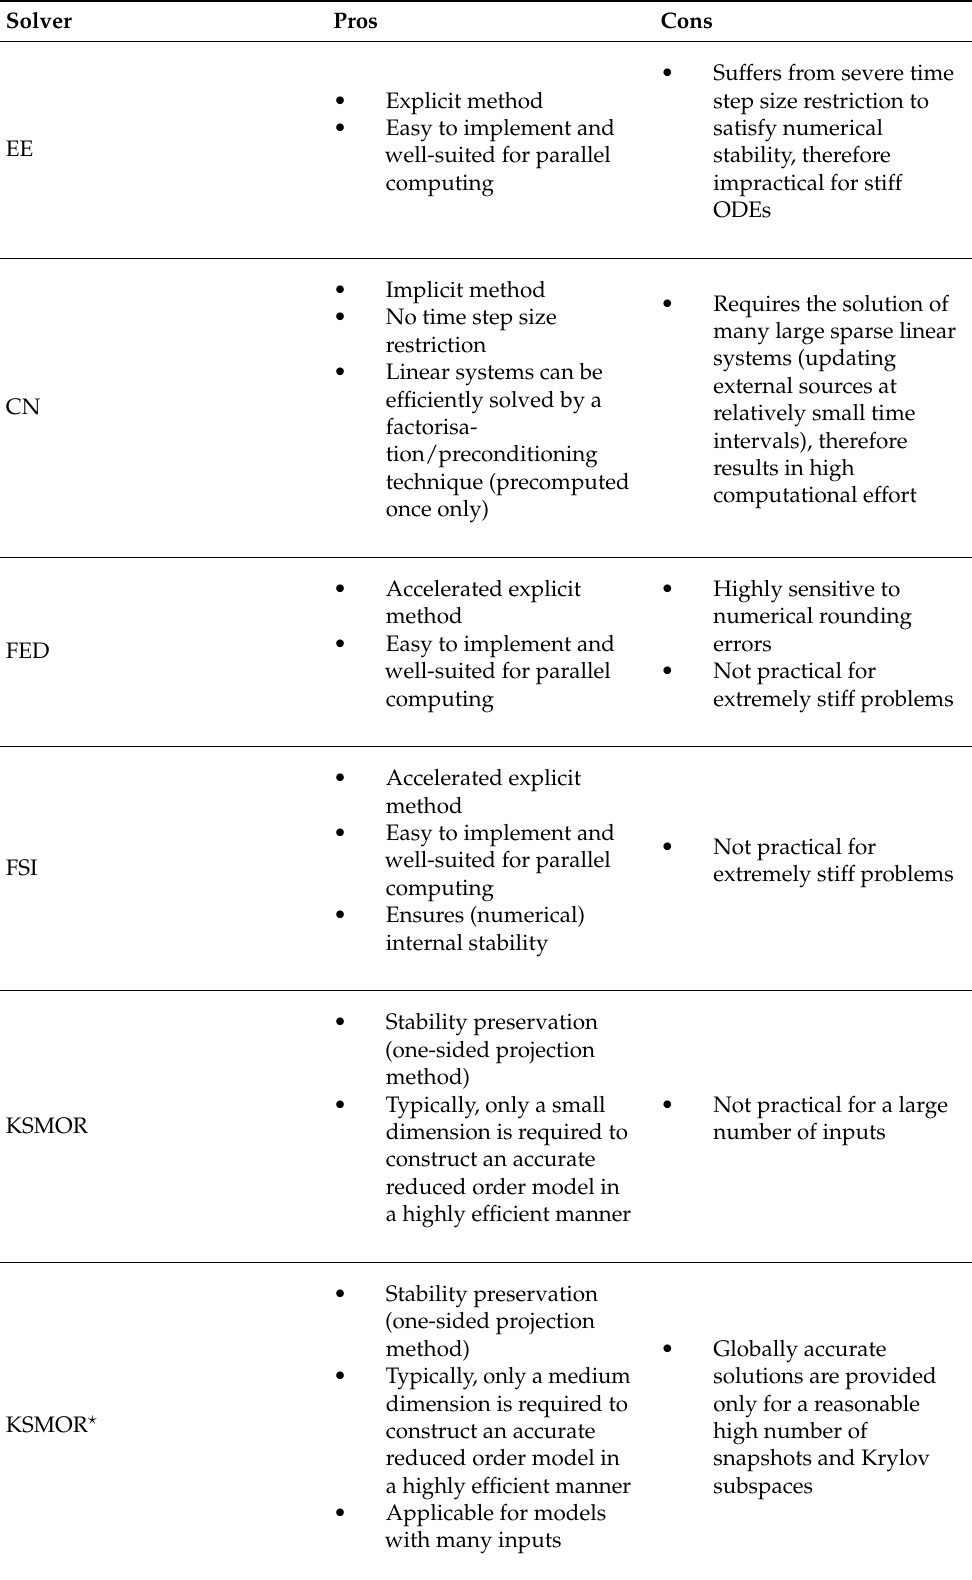
Table 2. Summary of numerical solvers presented in Section 4, focusing on classic explicit (EE) and implicit (CN) methods as well as two popular techniques, namely the fast explicit methods (FED and FSI) and the Krylov-based model order reduction techniques (KSMOR and KSMOR (cid:63) ).